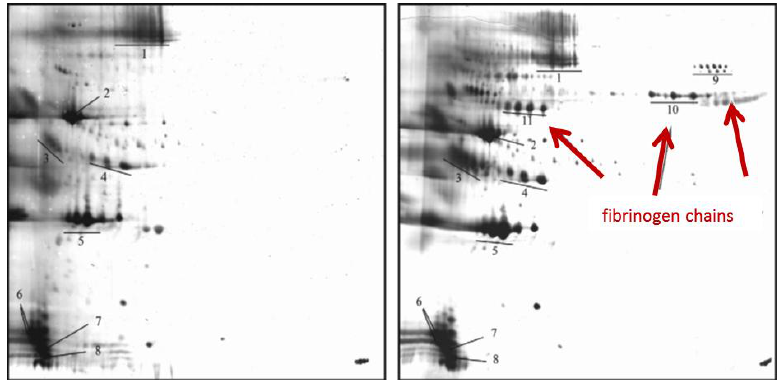
Figure 6. Comparison of silver stained gels of Lipofundin N 20% ( left ) and the amphotericin B-containing emulsion ( right ). Arrows mark the additional adsorbed fibrinogen chains. Protein spot number: (1) Albumin, (2) ApoA-IV, (3) ApoJ, (4)